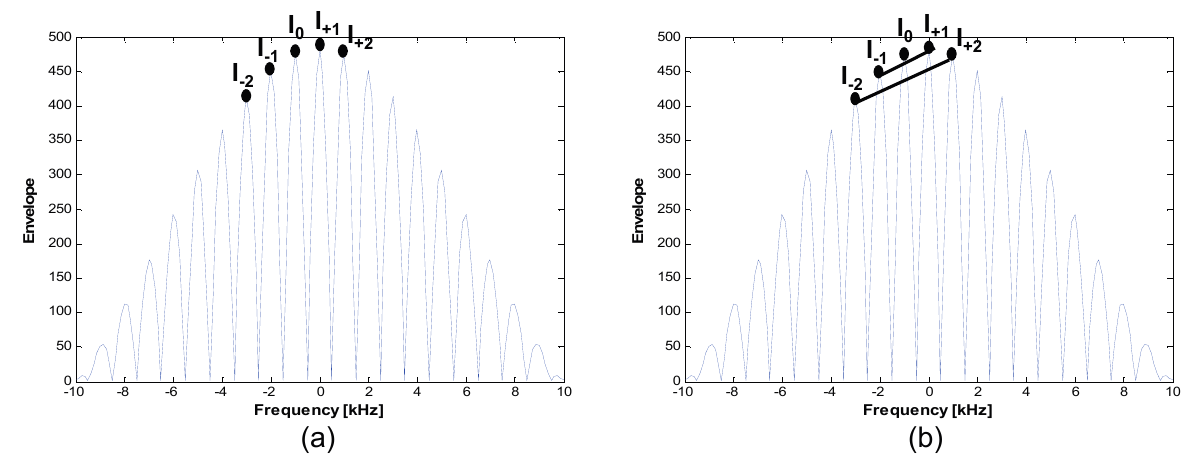
Figure 10. The false lock detection schemes: ( a ) The max peak finder; ( b ) The slope